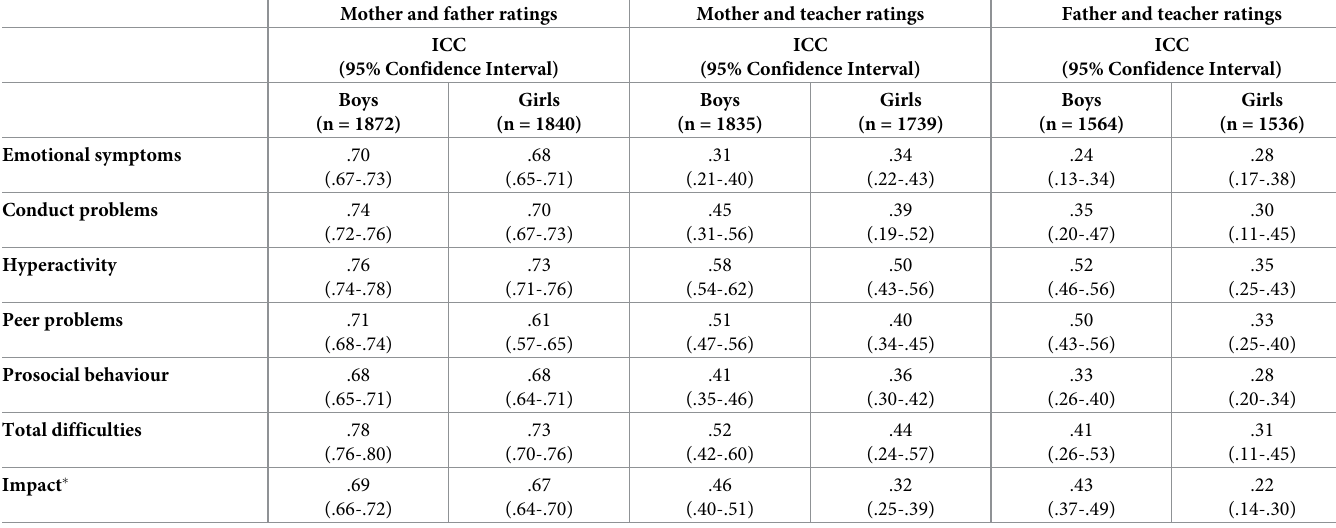
Table 7. Inter-rater agreement for SDQ scores by child